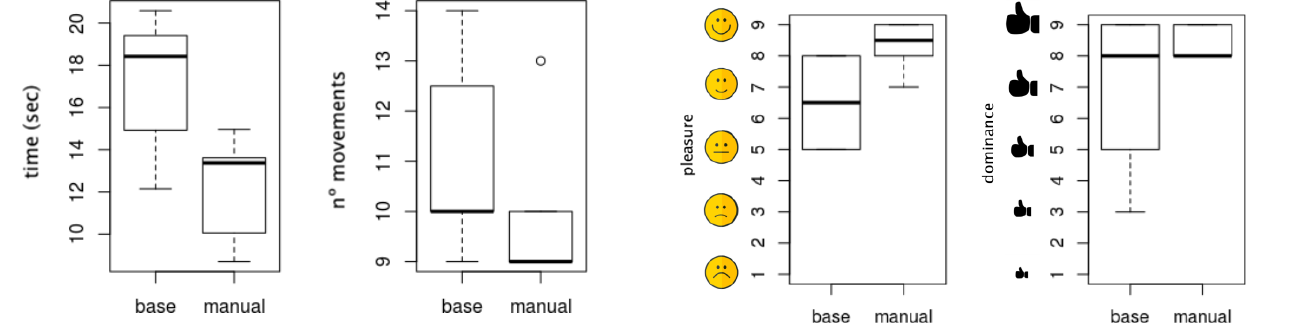
Fig. 3. Boxplots of task T2 to slideshow comparing the metrics of time and movements.